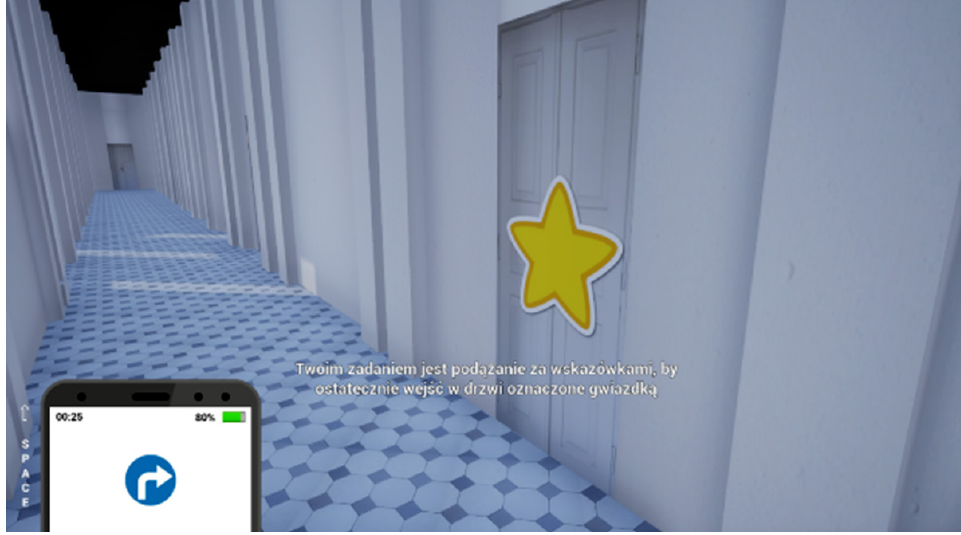
Fig. 10. Screenshot of a star indicating the destination of a stage. The Polish text reads: “Your task is to follow the directions to reach the door marked with a